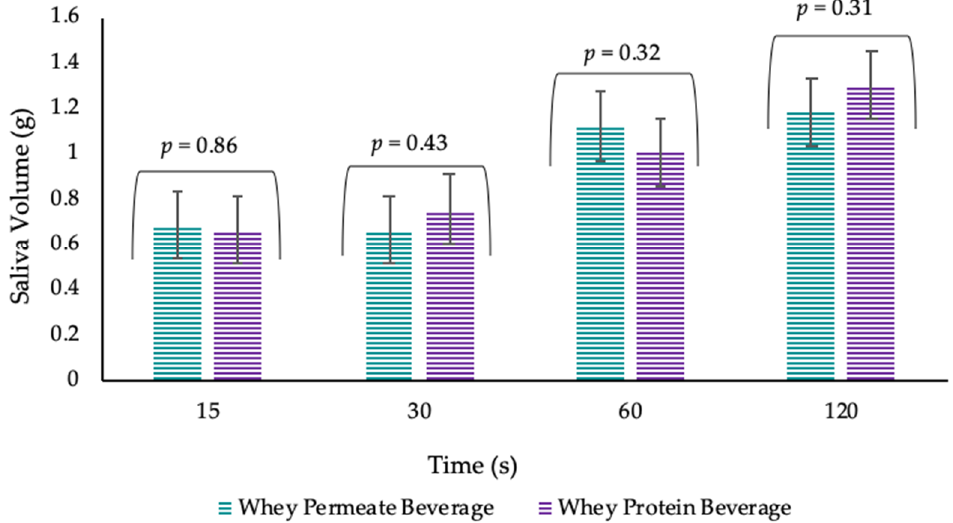
Figure A1. Saliva volume collected post beverage consumption by timepoints. Values are expressed LSM estimates ± standard error from SAS output. No significant di ff erences ( p < 0.05) were reported as LSM estimates ± standard error from SAS output. No significant differences ( p < 0.05) were reported between samples at all timepoints with relevant p value above each between samples at all timepoints with relevant p value above each timepoint.